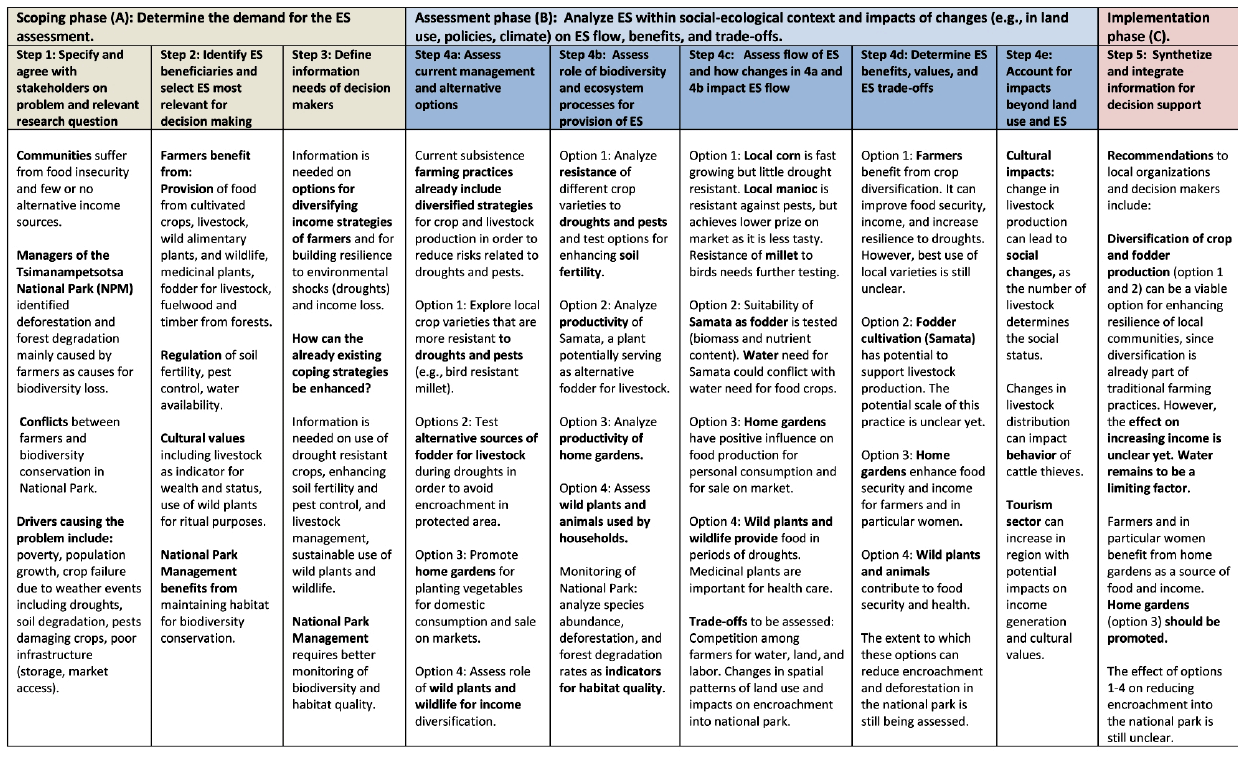
Fig. 3 . Problem-oriented approach for assessing ecosystem services (ES): the case of the SuLaMa project on subsistence farming in